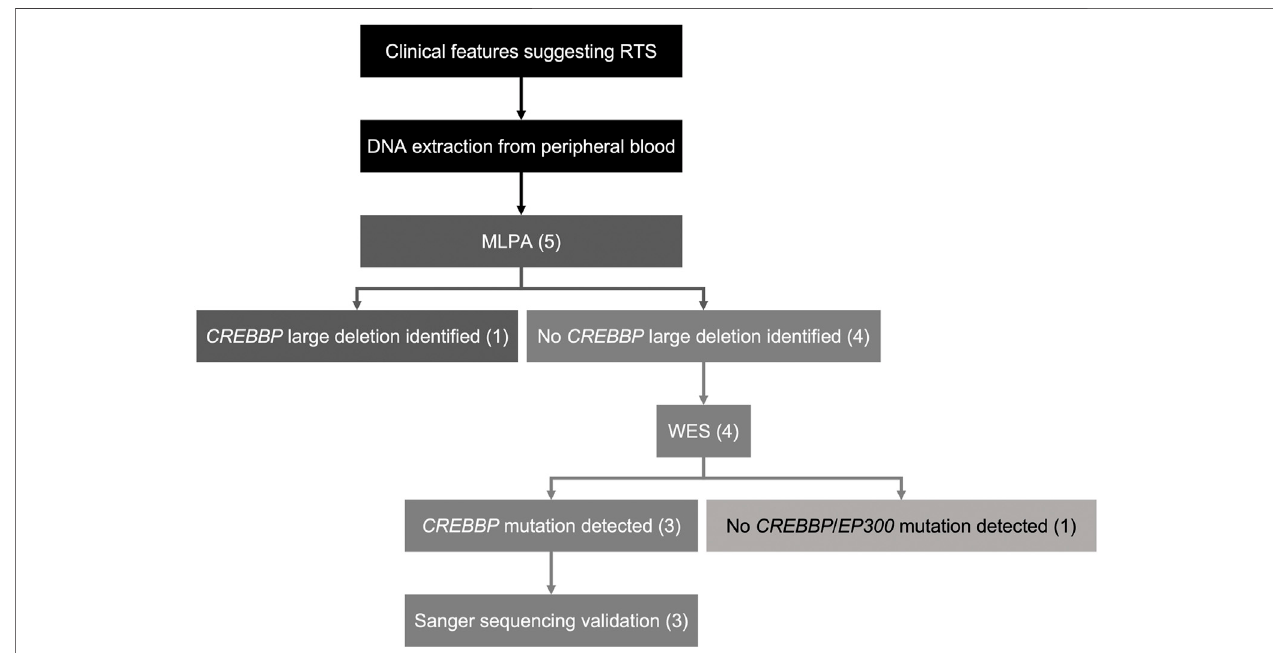
FIGURE 1 | Schematic ofthe diagnostic work fl ow in this study. Five patients clinically diagnosed with RSTS were enrolled. MLPA was done on DNA samples ofall the RSTS patients. 1/5 patient (20%) was found to harbor a large de novo deletion spanning CREBBP . WES was performed on DNA samples of the other four patients showing negative MLPA results. 3/5 patients (60%) were found to have novel CREBBP mutations with high pathogenicity scores. 1/5 patient (20%) showed negative results for MLPA and WES.